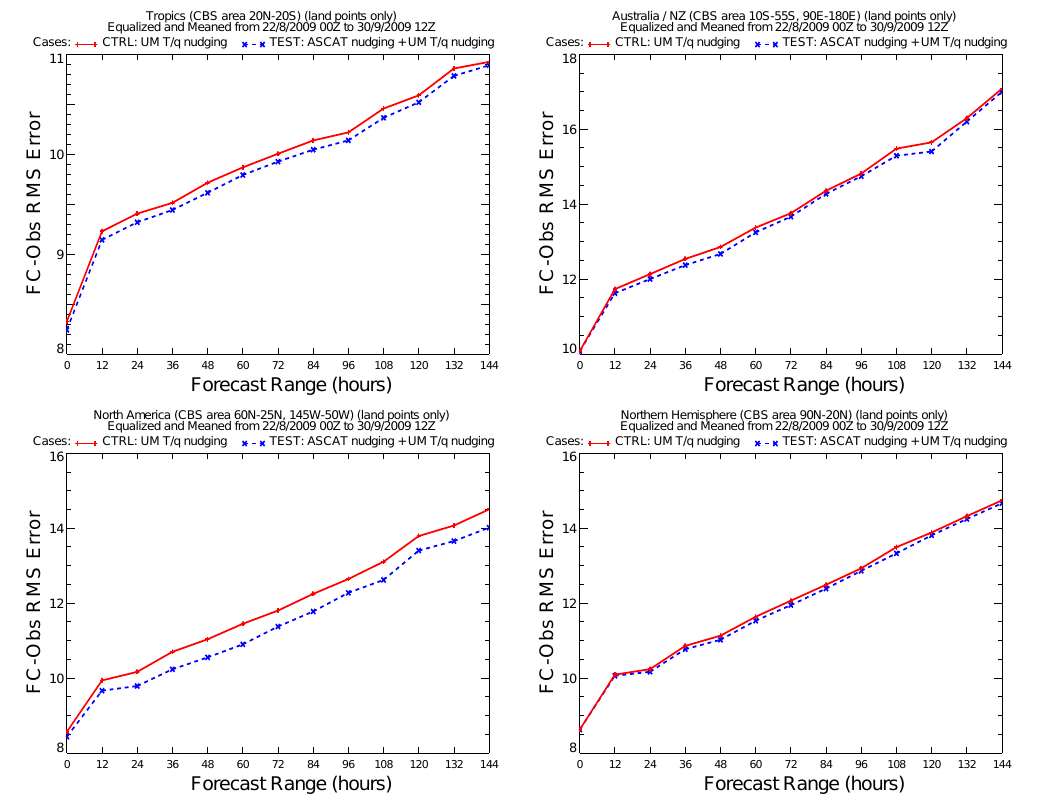
Fig. 10. Trial 2 verification of UM screen relative humidity forecasts against observations for land points only and the time period 22 Aug 2009 to 30 Sep 2009. The solid red lines (dashed blue lines) show RMS differences for the control experiment (test experiment that also assimilates ASCAT surface soil wetness measurements). Results are shown for the tropics (20S to 20N), Australia (55S to 10S, 90E to 180E), North America (25N to 60N, 145W to 50W) and Northern Hemisphere regions (20N to 90N). 41